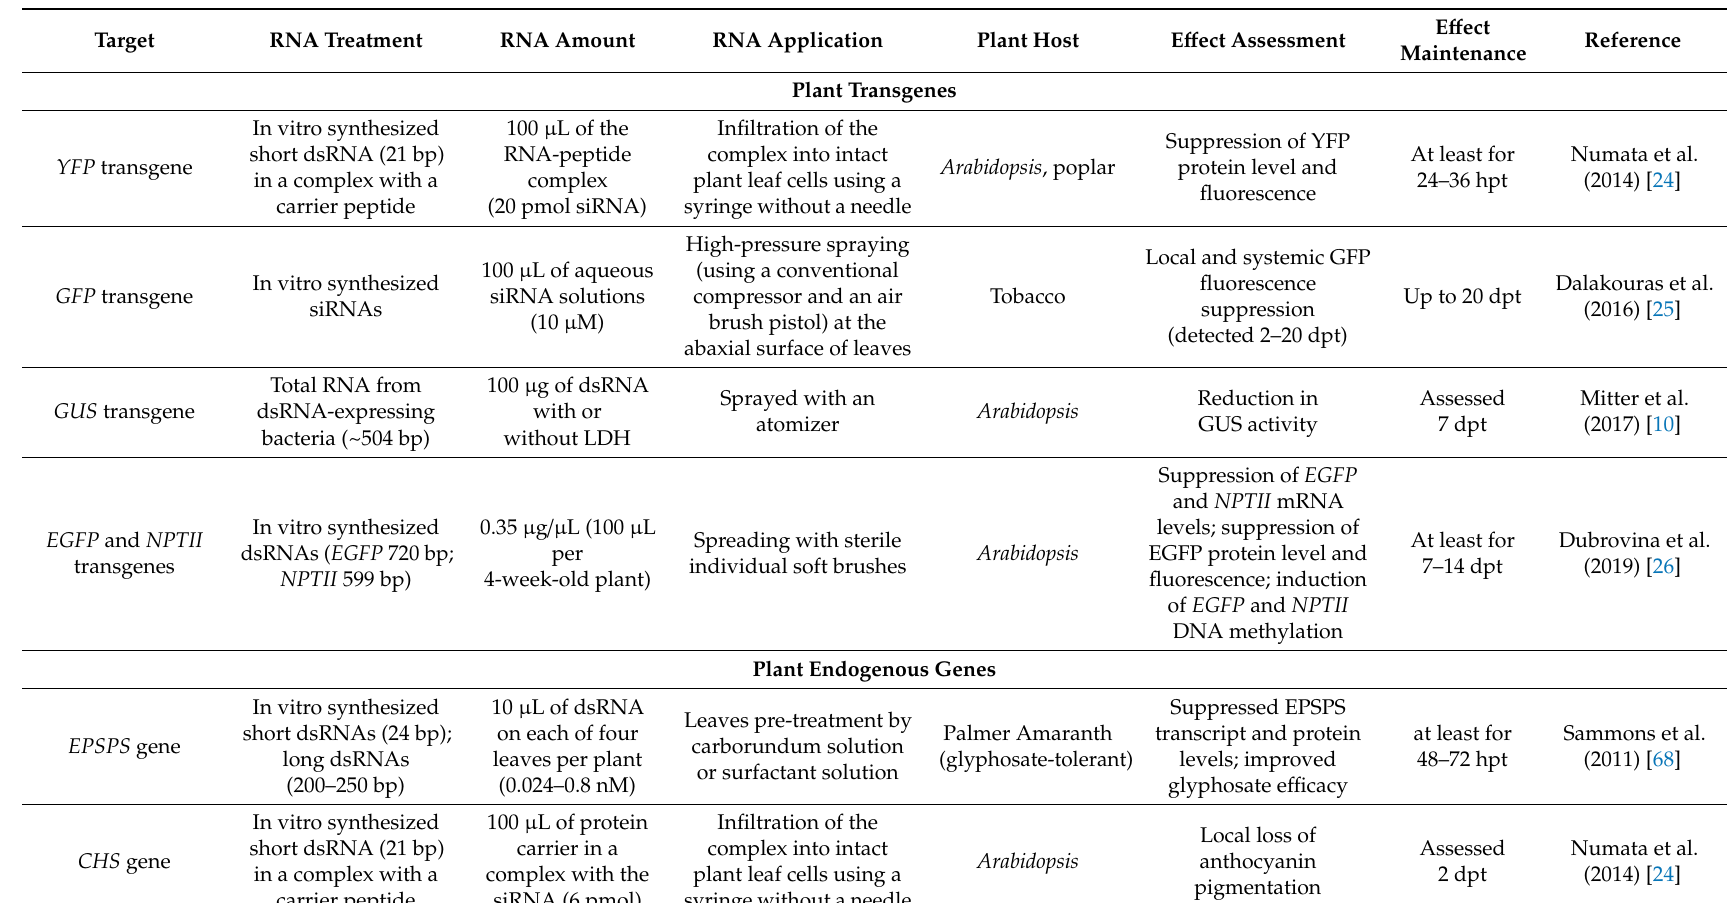
Table 4. Application of external RNAs for the suppression of plant transgenes or endogenous